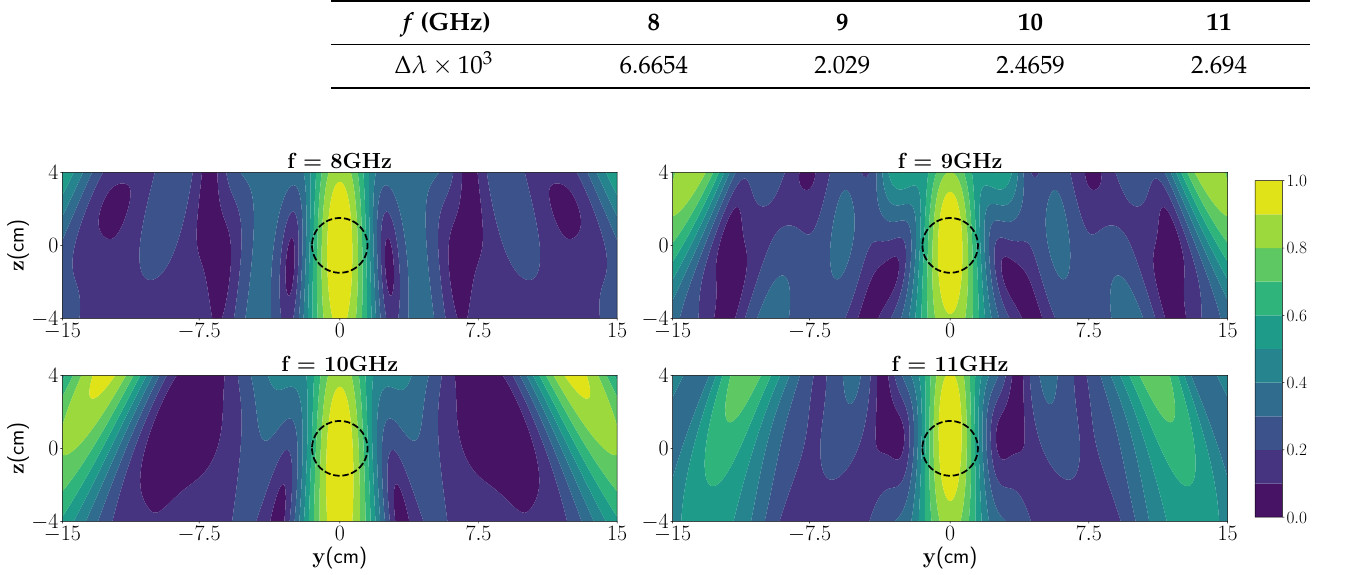
Figure 9. Reconstruction using SF-TRI-DORT at four